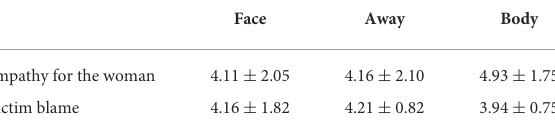
TABLE 2 Means and standard deviations of empathy for the woman in the video and victim blame as a function of manipulation condition (face, away,